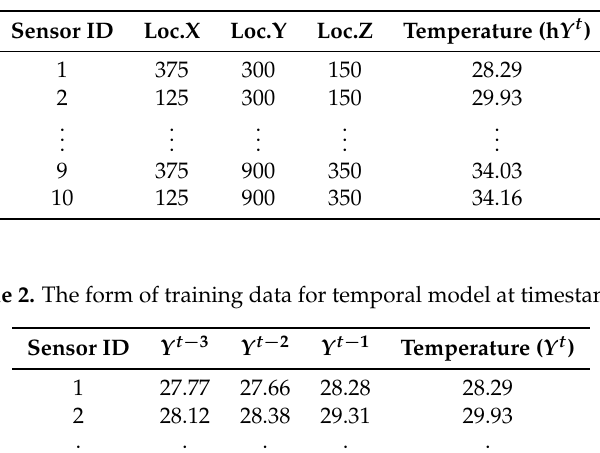
Table 1. The form of training data for spatial model at timestamp t .